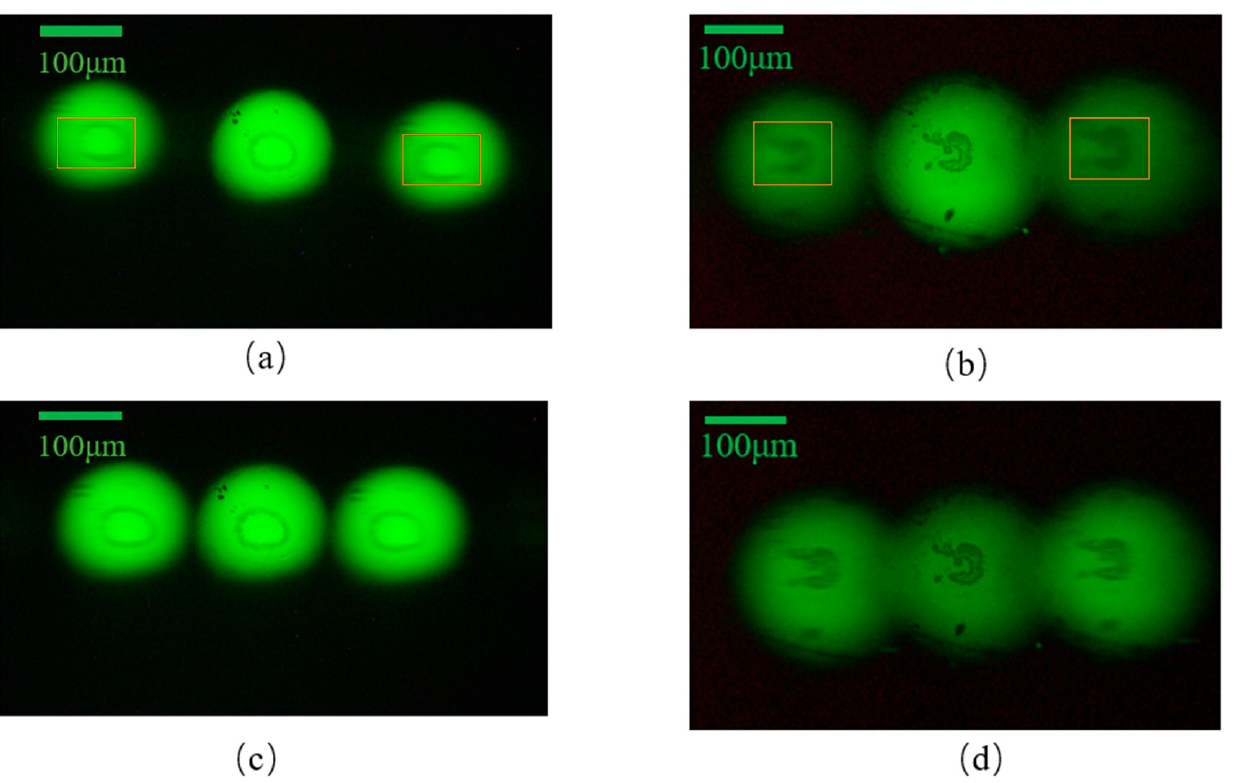
Figure 15. Results of experiment using chromatography microscopy with 5 × objective lens with: ( a , b ) Off-axis Fresnel zone plate; ( c , d ) aberrated off-axis Fresnel zone plate.